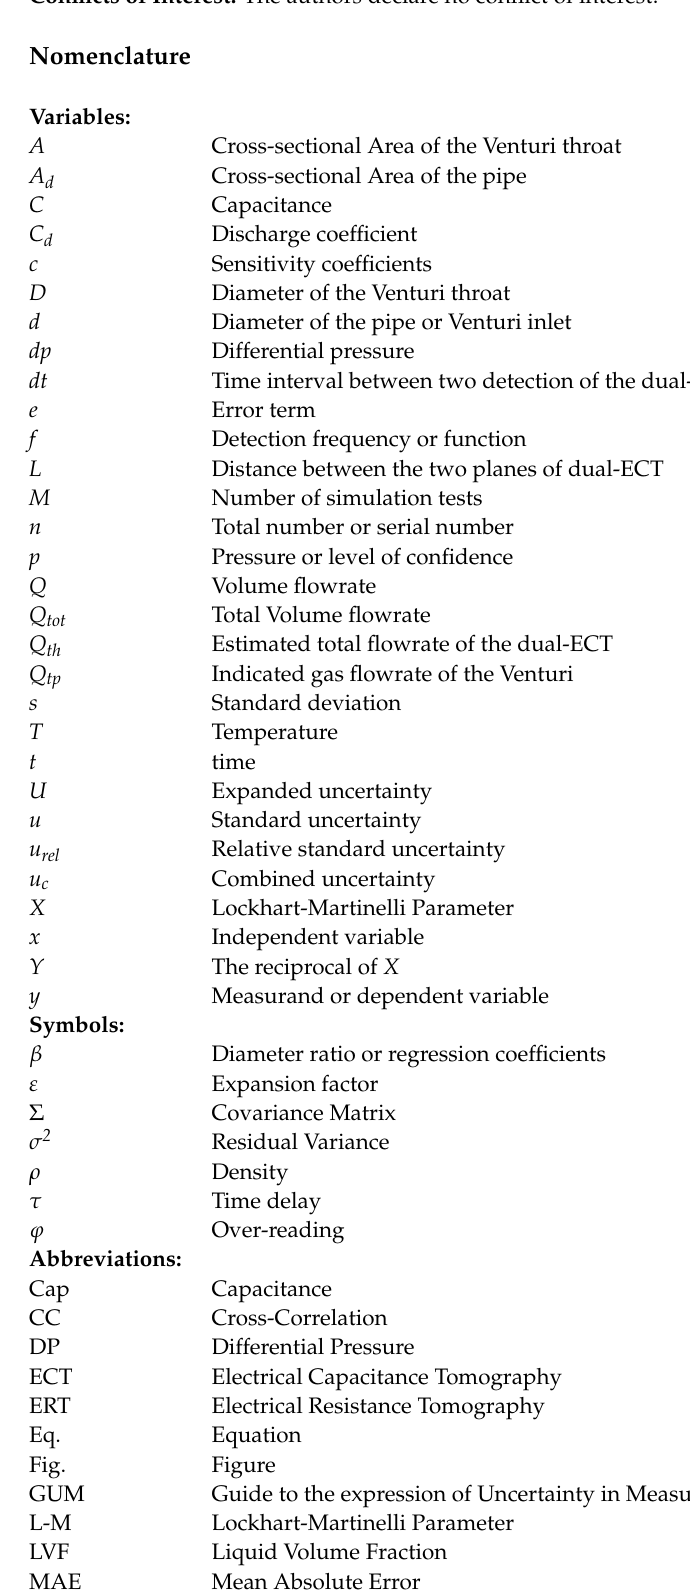
Guide to the expression of Uncertainty in